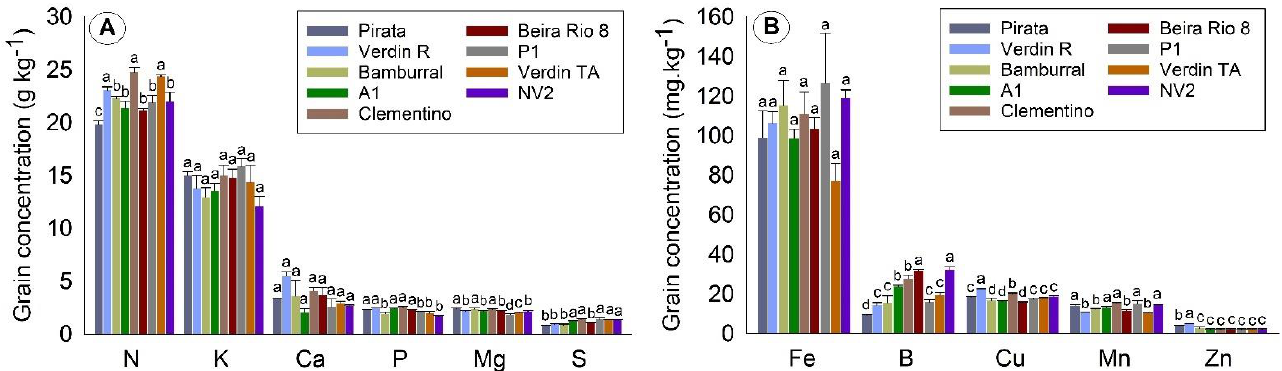
Figure 2. Concentration of macronutrients ( A ) and micronutrients ( B ) in grains of nine Coffea canephora genotypes. São Mateus, state of Espírito Santo — Brazil. Means followed by the same letter for each nutrient do not differ by the Skott–Knot test at 5% probability.